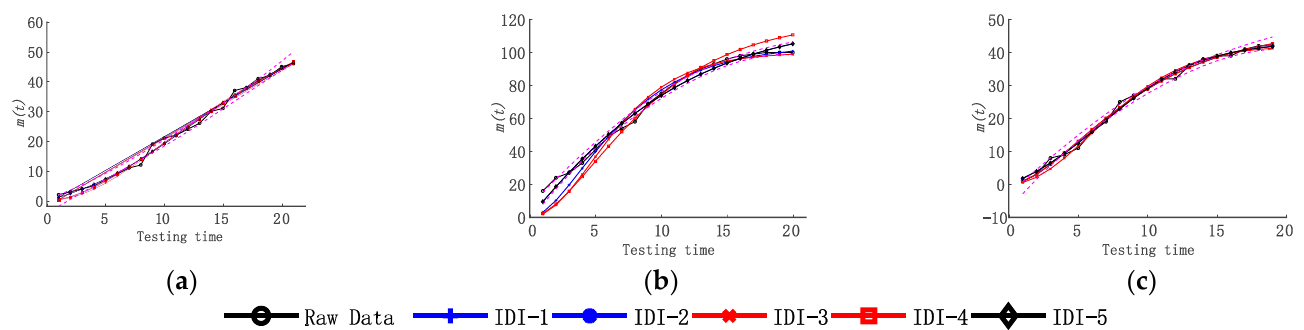
Figure 2. IDI Model Fitting Curve. ( a ) IDI Model Fitting Curve on DS1; ( b ) IDI Model Fitting Curve on DS2; ( c ) IDI Model Fitting Curve on DS3. Table 2. Performance indicators of IDI-type models.